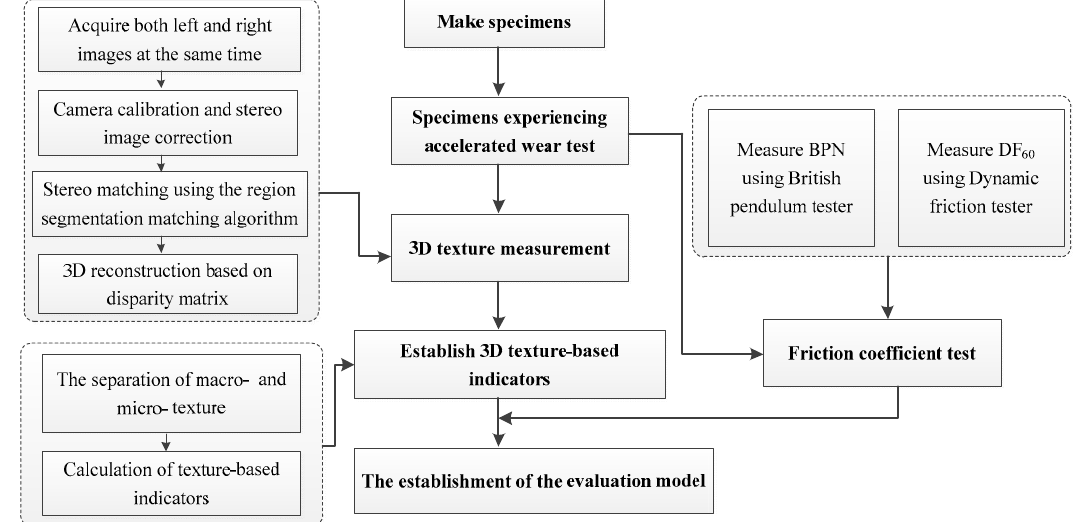
Figure 1. The research program in this study.